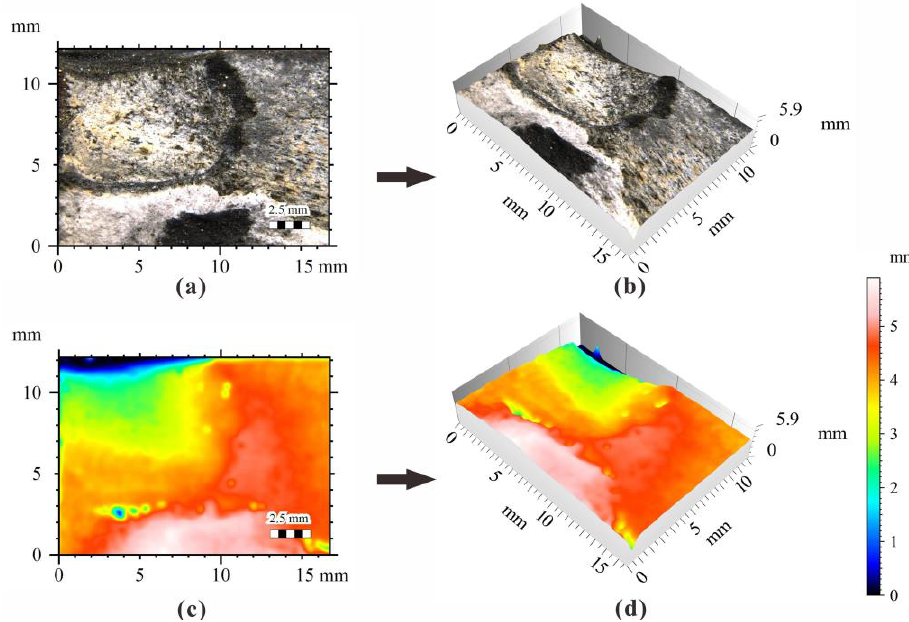
Figure 10. 2D and 3D Montage images of fracture surfaces and corresponding depth maps. ( a ) 2D Montage image, ( b ) 3D Montage image, ( c ) 2D depth map, and ( d ) 3D depth